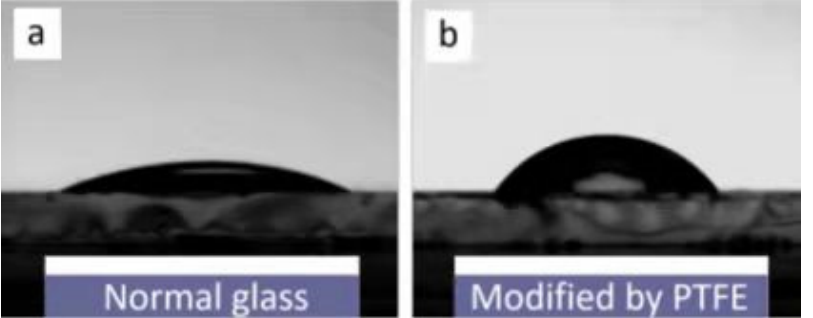
Figure 5. The contact angle test results of ordinary glass substrate and PTFE modified glass sub- strate. ( a ) The ordinary glass substrate; ( b ) The glass substrate modified by PTFE. ( a ) The ordinary glass substrate; ( b ) The glass substrate modified by